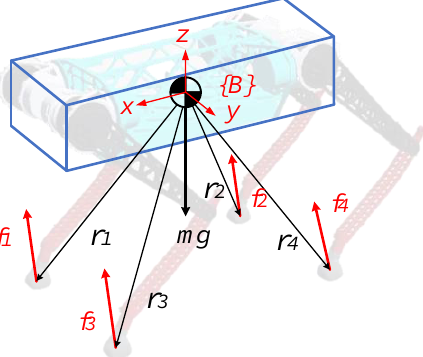
Figure 6. Single rigid body model of a quadruped robot.